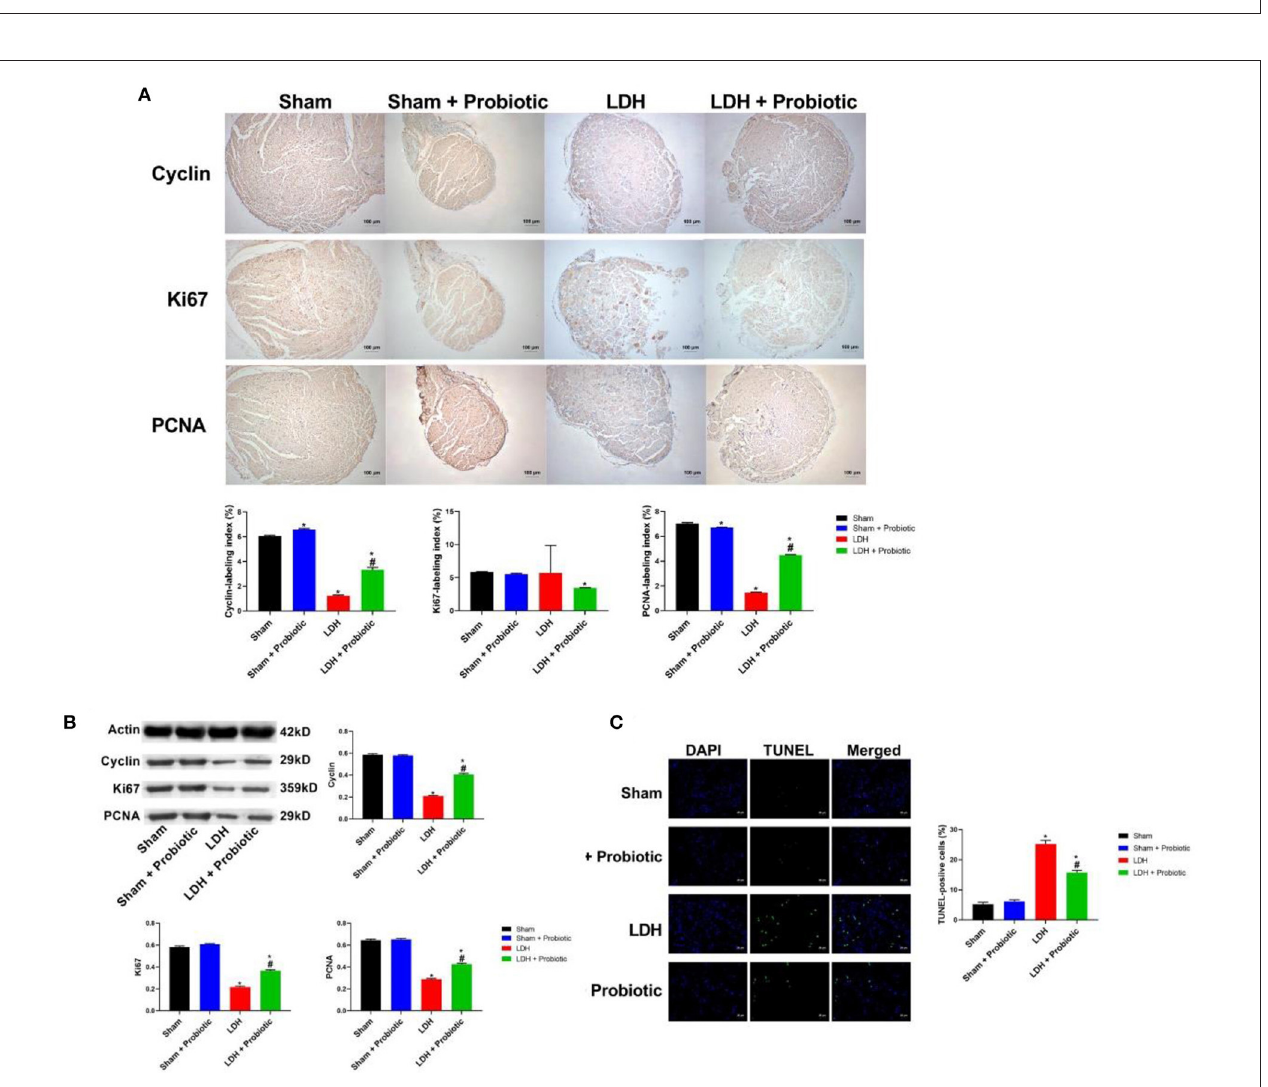
FIGURE 2 | L. paracasei S16 elevated the expression of cell proliferation markers in LDH mice. (A) Cyclin, Ki67, and PCNA protein expression in the DRG was examined by immunohistochemical staining; (B) Western blot analysis of cyclin, Ki67, and PCNA in DRG; (C) TUNEL analysis of DRG. Data were expressed as the mean ± SEM. * P < 0.05 vs. Sham; # P < 0.05 vs. LDH.